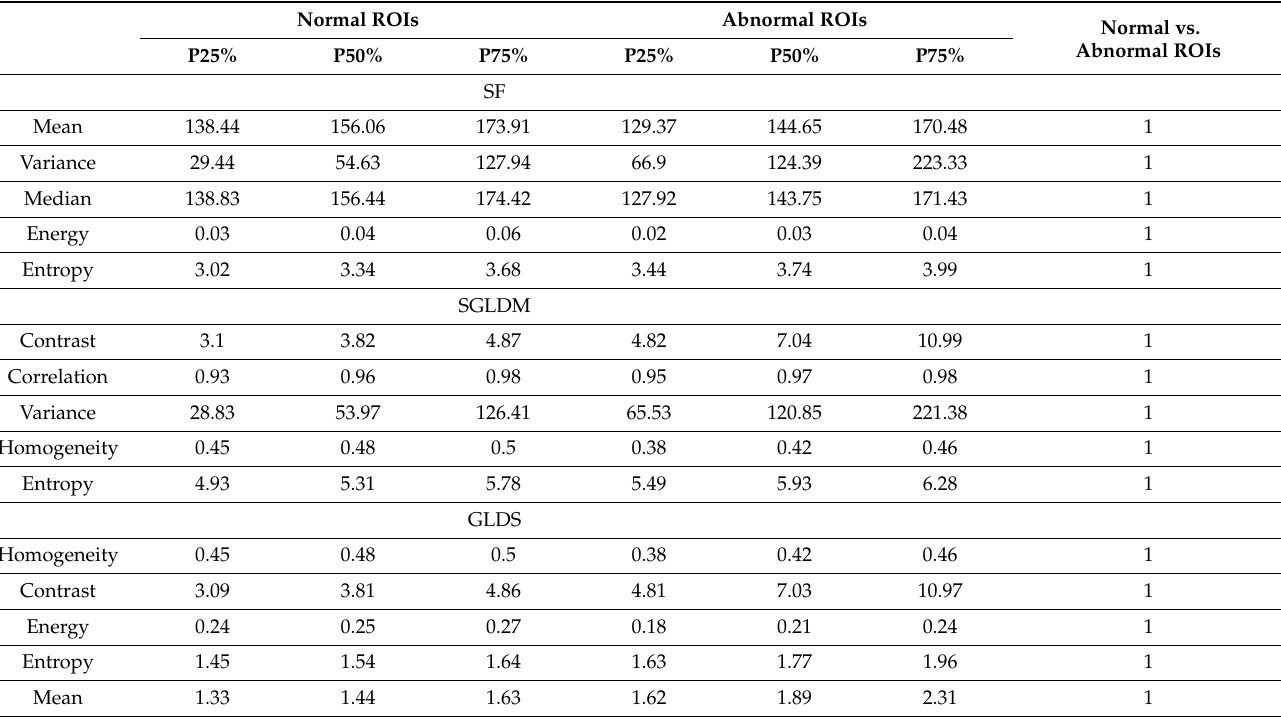
Table 1. Percentile values of the texture features and statistical analysis for normal ( n = 209) vs. abnormal ( n = 209) ROIs of the endometrium extracted from 40 women. Statistical analysis was carried out after gamma correction between the normal/abnormal ROIs at a ≤ 0.05 [7]. P25%, P50% and P75% correspond to the 25th, 50th (median) and 75th percentiles, respectively. Normal